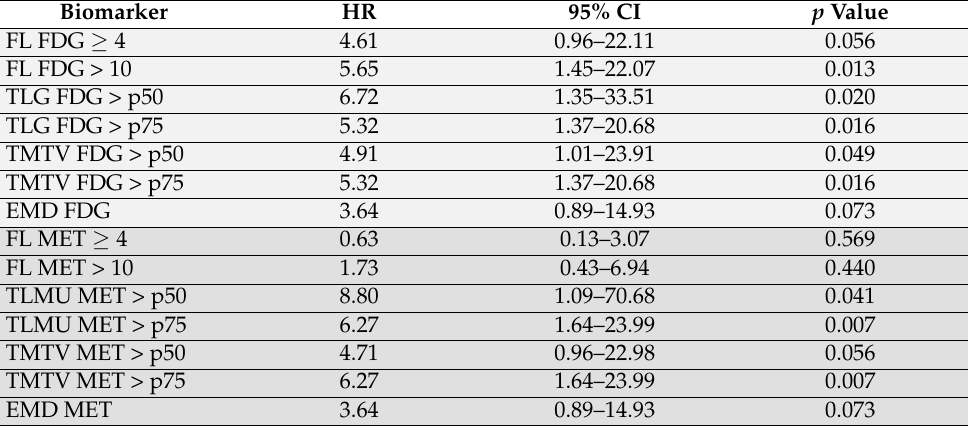
Table 6. Univariate analysis of Baseline FDG and MET biomarkers in clinical outcomes (PFS) in relapsed